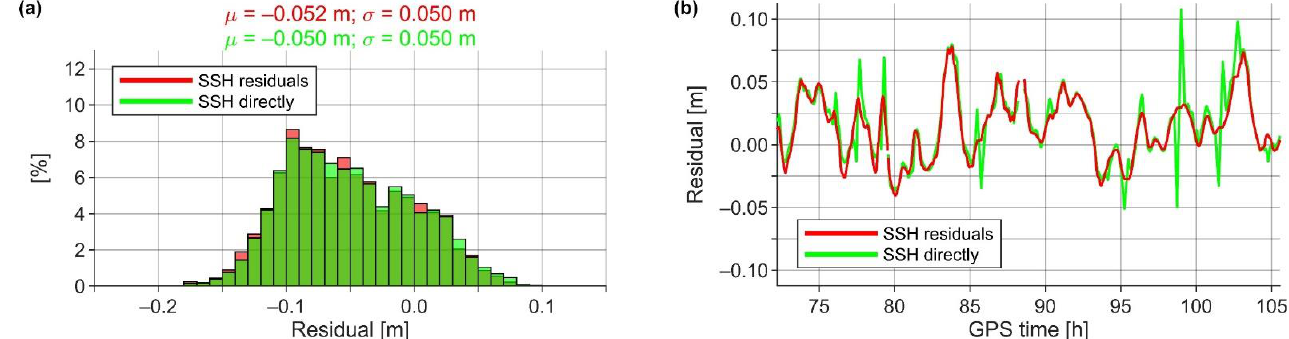
Figure 19. ( a ) Histograms of residuals (all campaigns combined): the impact of the data filtering approach, and ( b ) a comparison between residuals (a section of campaign C3) resulting from two approaches.